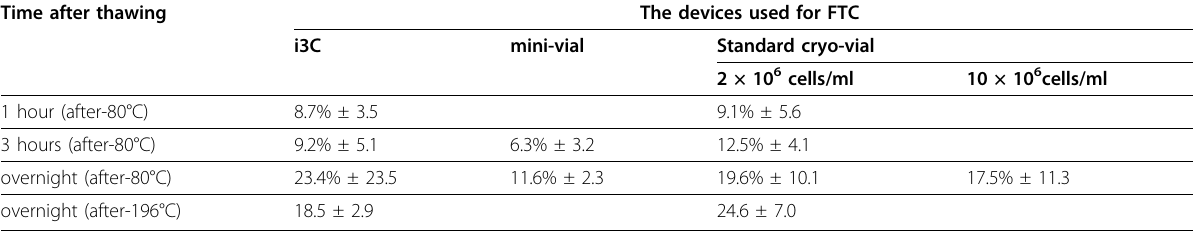
Table 1 Cell death in U937 cells after the freezing - thawing cycle Time after thawing